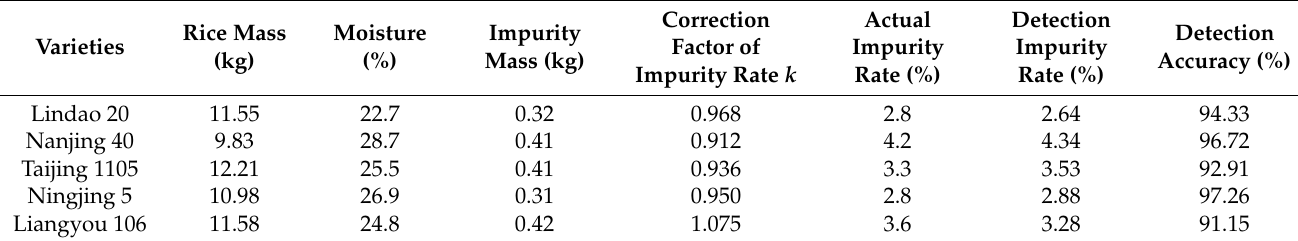
Table 5. Bench test result.